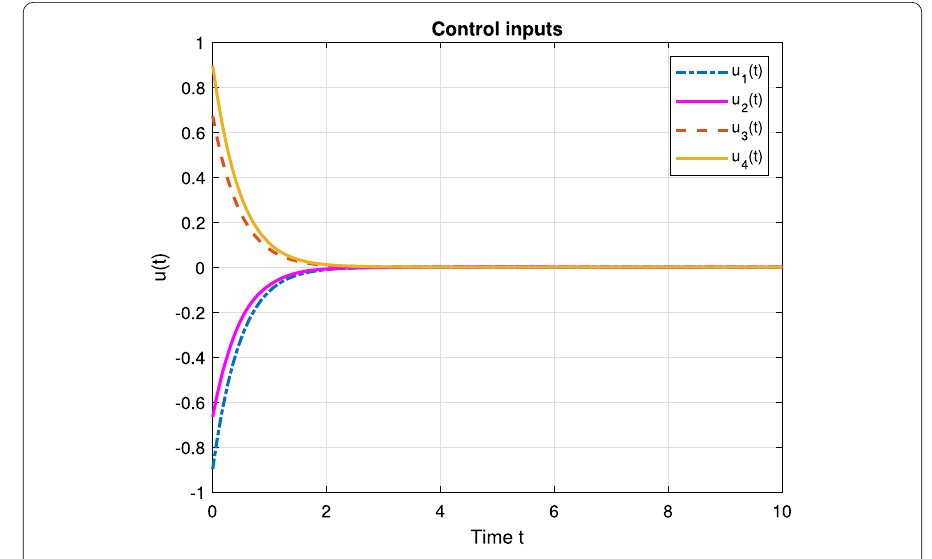
Figure 9 Control inputs for the GNNs (47) in Example 4.4